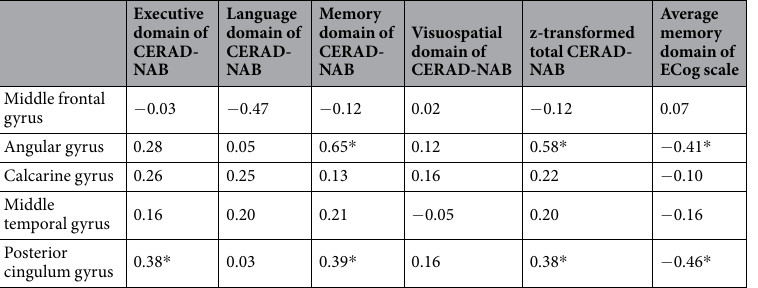
Table 5. Pairwise correlation analysis between regional SUVr, different cognitive domains of CERAD-NAB and memory domain of ECog scale in patients with early stage of probable AD. Abbreviations: SUVr, Standard Uptake Value ratio; ECog, Everyday Cognition; CERAD-NAB, Consortium to Establish a Registry for Alzheimer’s Disease Neuropsychological Assessment Battery; AD, Alzheimer’s disease. Tested by spearman’s rank correlation. * P <